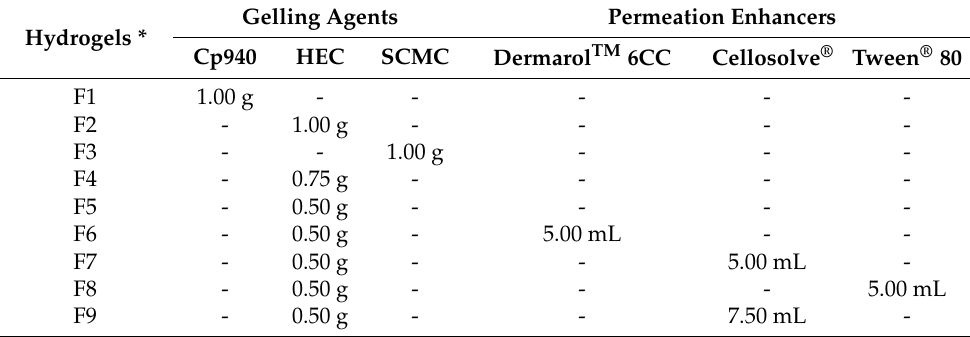
Table 1. Composition of BH